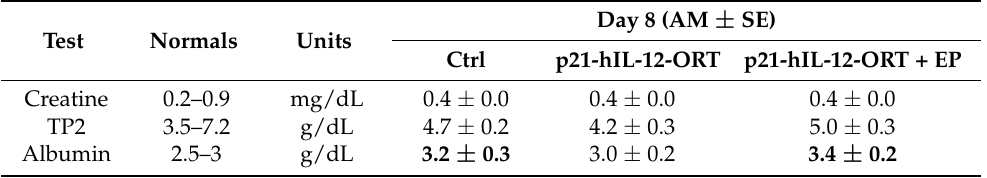
Table 2. Blood chemistry 8 days after p21-hIL-12-ORT GET to B16F10 mouse melanoma